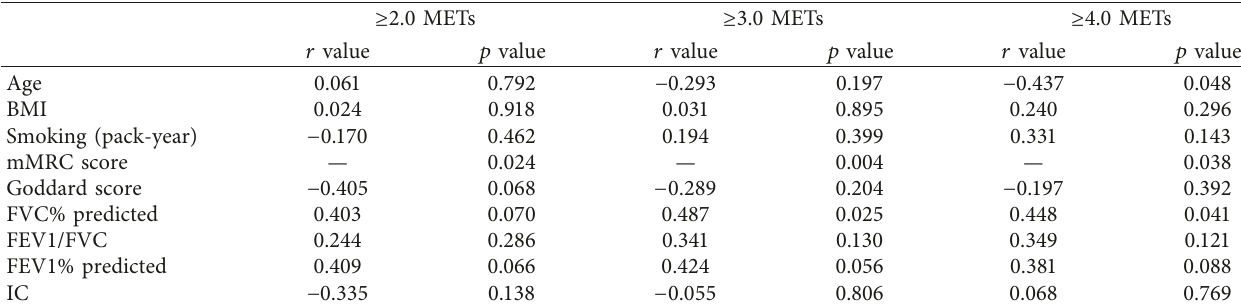
Figure 4: Repeatability of the measurement. Triangle indicates the duration at ≥ 2.0 METs; square indicates the duration at ≥ 3.0 METs; circle indicates the duration at ≥ 4.0 METs. METs: metabolic equivalents; ICC: intraclass correlation coefficient. Table 2: Correlations between physical activity and demographic